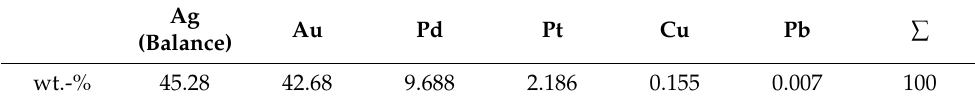
Table 4. Chemical composition of a typical leaching residue (optimum leaching conditions). Ag (Balance)